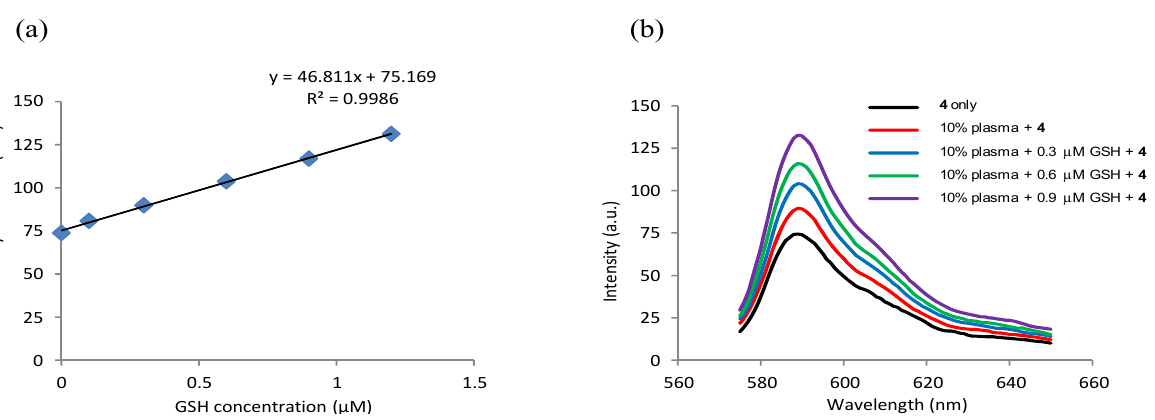
= 565 nm, ex = 565 nm) ex